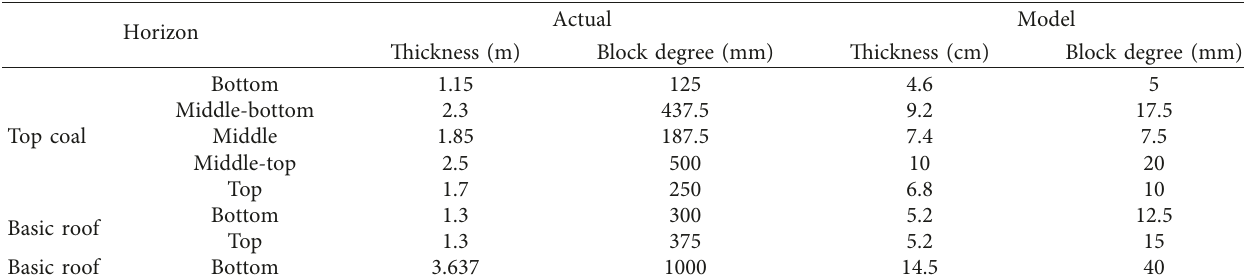
Table 6: Experimental scheme for dissipation of top coal in coal seams with three soft and complex structures.